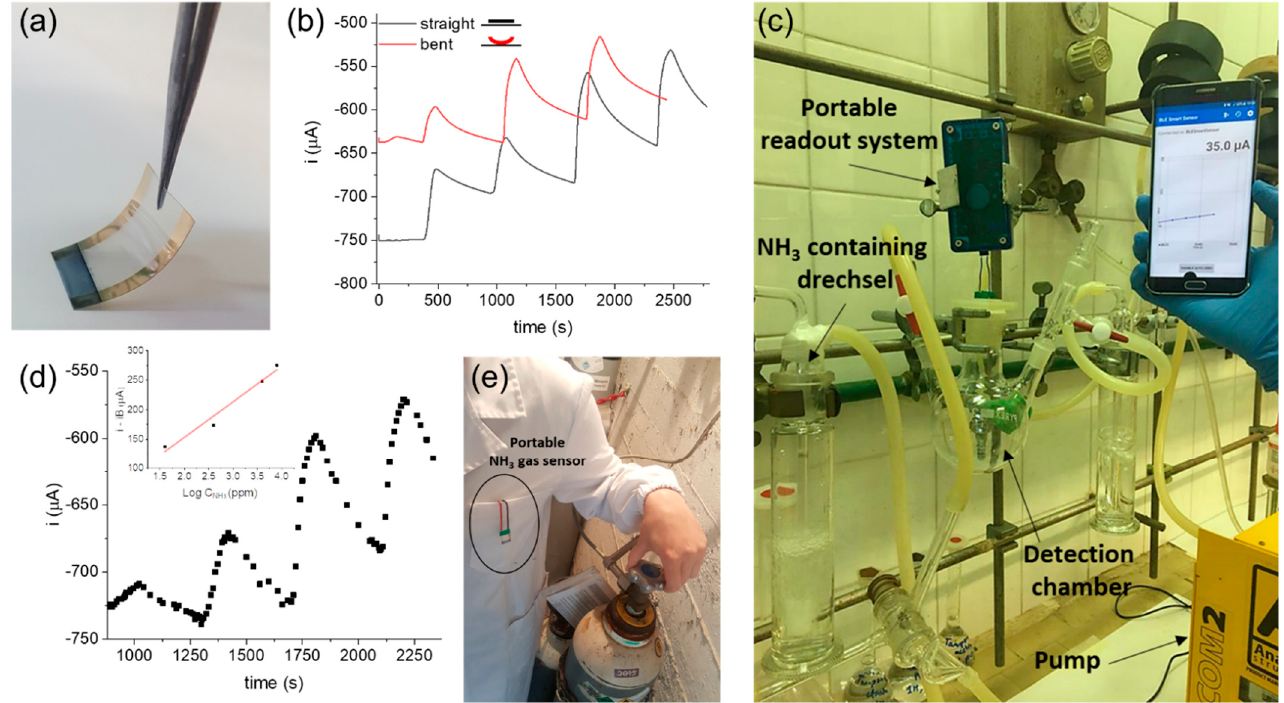
Figure 6. ( a ) Picture of the flexible two-terminal sensor. ( b ) Current vs. time response of the flexible NH 3 sensor in the straight and bent configurations. ( c ) Picture of the flexible gas sensor detecting NH 3 interfaced with a portable readout electronic system, which was wirelessly connected to a smartphone application via Bluetooth. ( d ) Real-time response of the flexible sensor in the portable configuration. Inset: calibration curve (R 2 = 0.953). ( e ) Picture of the gas sensor placed in the breast pocket of a lab coat, simulating a real-life use for personal safety.